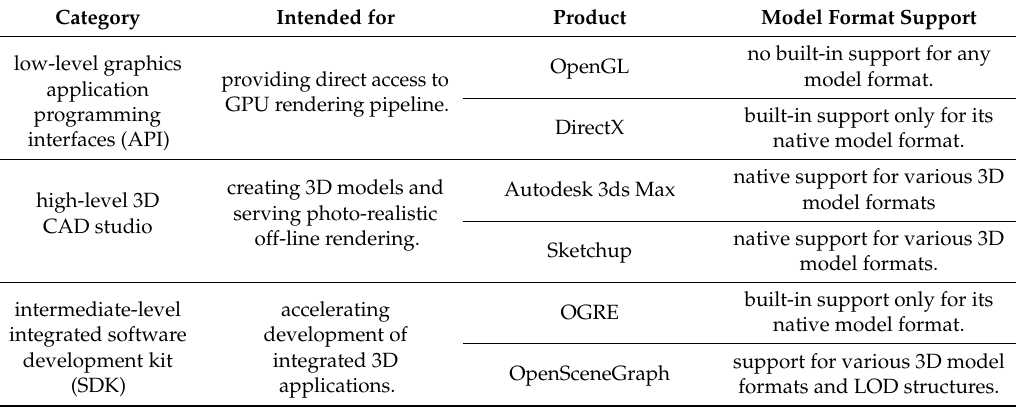
Table 2. Comparative review of mainstream 3D rendering